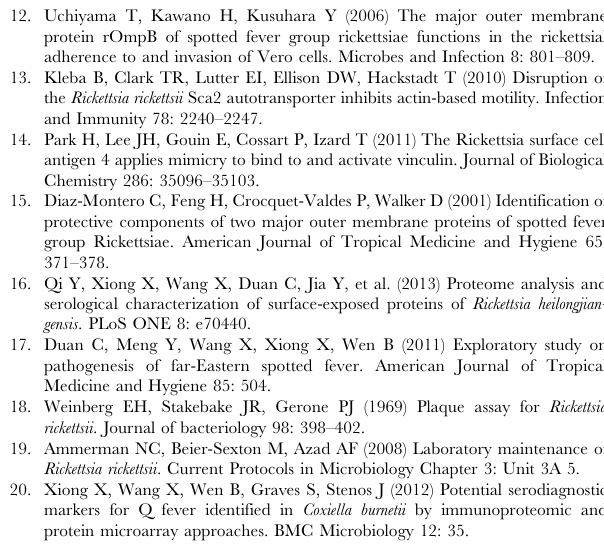
Figure S4 Comparison analysis of Porin_4 amino acid sequences from spotted fever group rickettsiae. Porin_4 amino sequences between R. rickettsii (list on the top line) and other spotted fever group rickettsiae (list under the R. rickettsii line) were compared by CLC Genomic Workbench V3.6.1 software (CLC